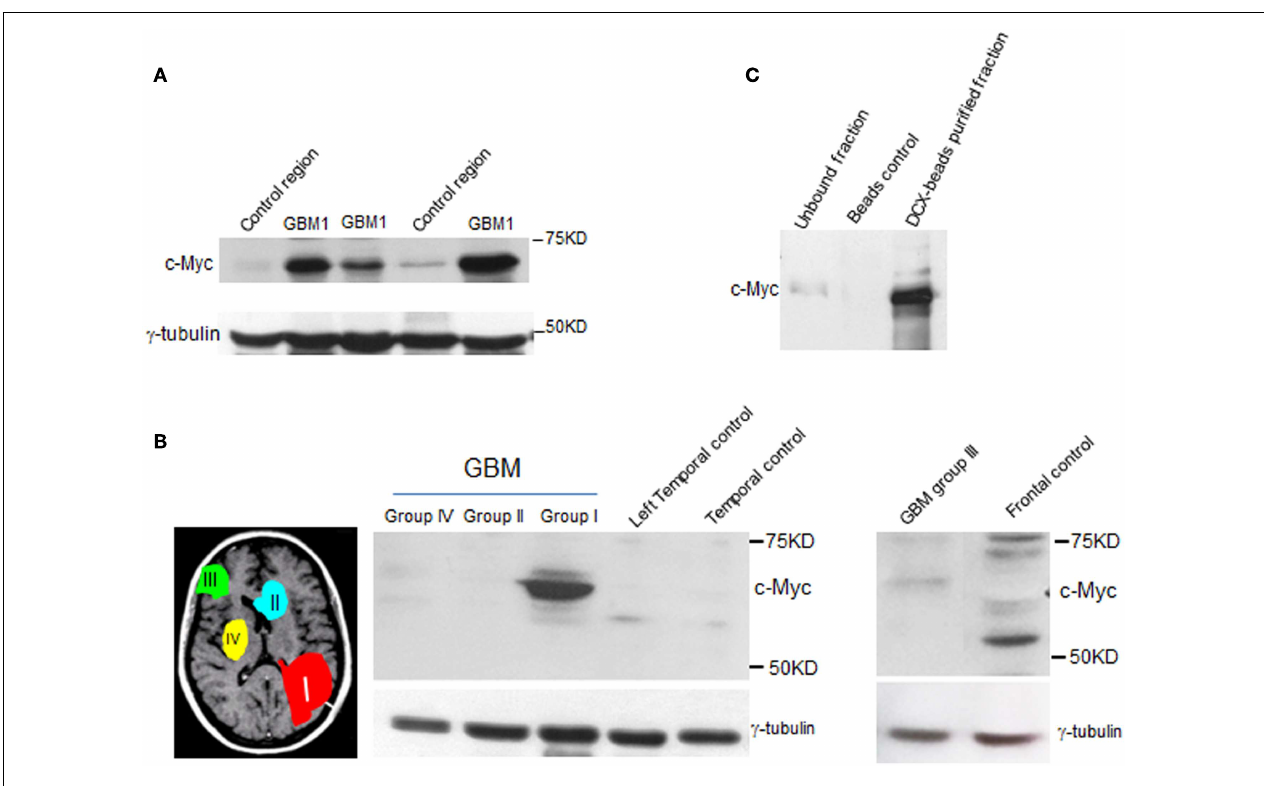
non-cancer donors that were regional and age matched to the MRI characterized GBM specimens. γ -tubulin was used as internal control. (C) c-Myc level is abundant in DCX-enriched population from GBM1